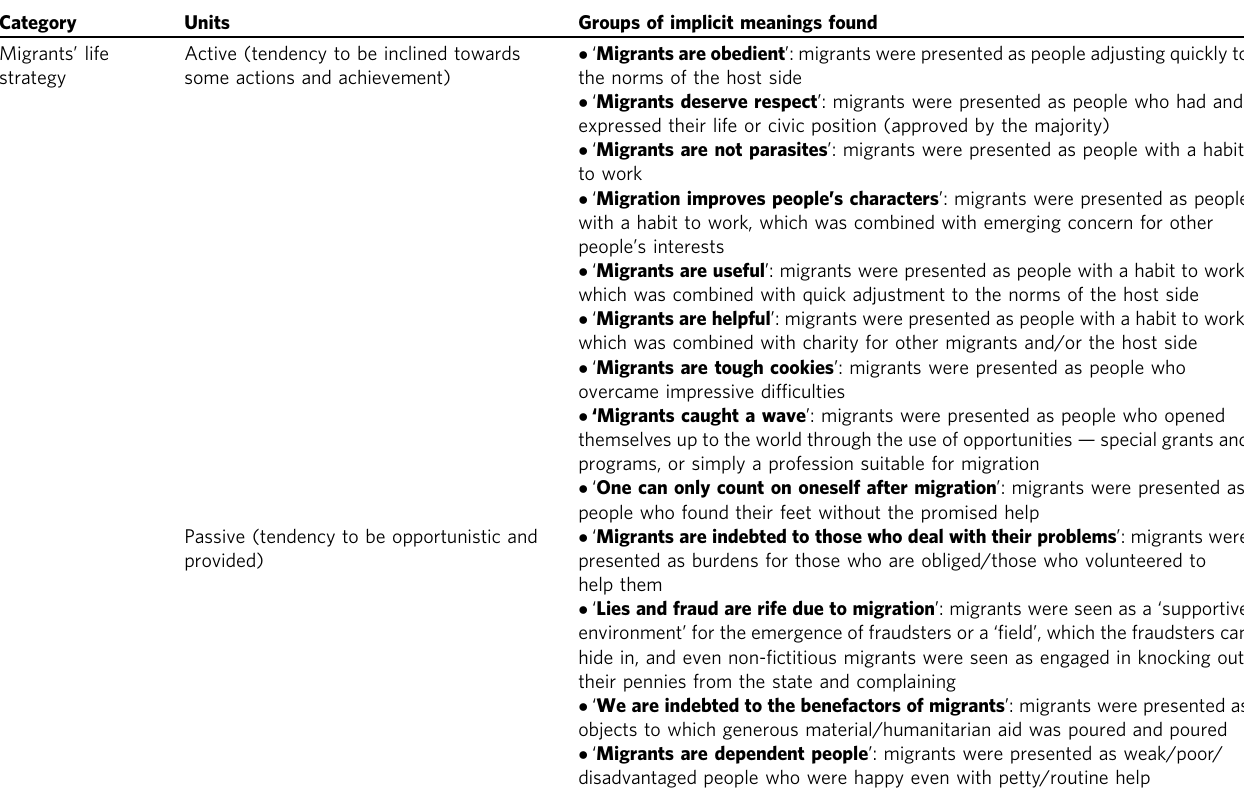
Table 1 Ukrainian top media implications regarding migrants ’ life strategy. Category Units Groups of implicit meanings found Migrants ’ life